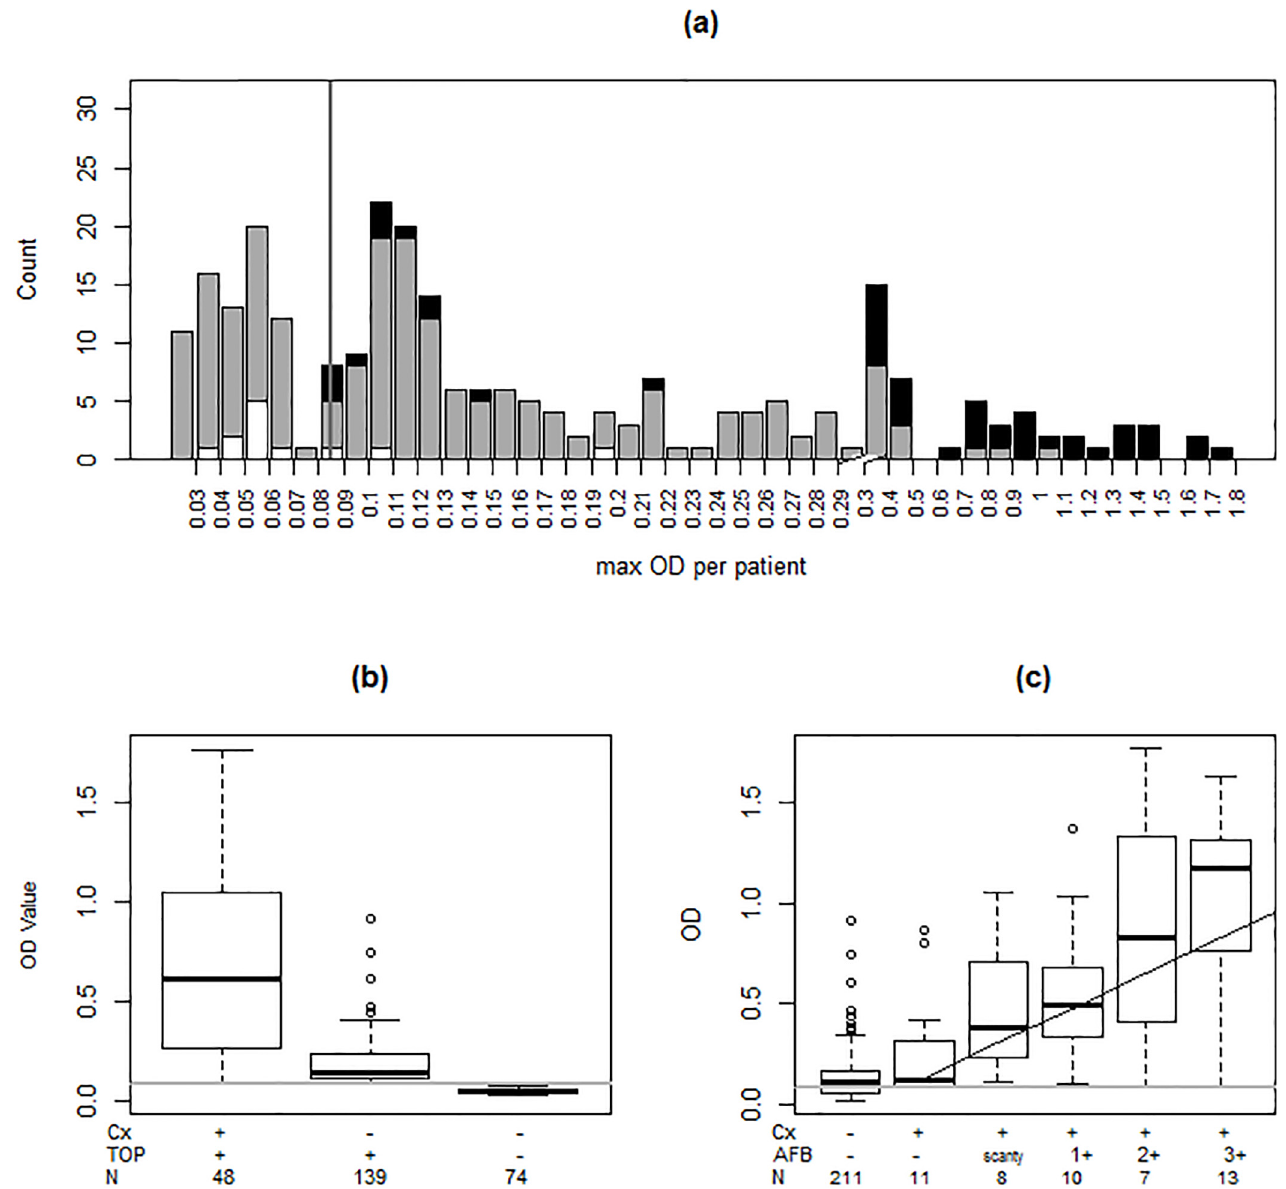
Fig 2. TOP TB assay results in 261 HIV-infected TB suspects from Mbarara, Uganda. (a) Vertical line denotes the laboratory cut-off TOP OD (0.0854) for a positive test. Histograms represent the number of subjects with culture-positive (black), culture-contaminated (white) and culture- negative (grey) results, by TOP OD values. The X-axis is zoomed-in at the lower end of TOP OD values (0.100 to 0.300) to show the large number of subjects in this section of the graph. (b) Group TOP OD values according to culture (Cx) and TOP results (group means are 0.67, 0.19, and 0.05, from left to right). The mean TOP OD of culture-positive/TOP-positive (0.67) samples was higher than in culture-negative/TOP-positive (0.19, P < 0.0001), suggesting a low bacterial load content in many HIV-infected TB suspects. (c) Median TOP ODs paralleled sputum AFB grades (P < 0.0001), demonstrating the semi-quantitative performance of the TOP TB assay. One subject with a scanty AFB reading and a contaminated culture was excluded (TOP OD 0.103). A smoothing spline fit to the data is shown.